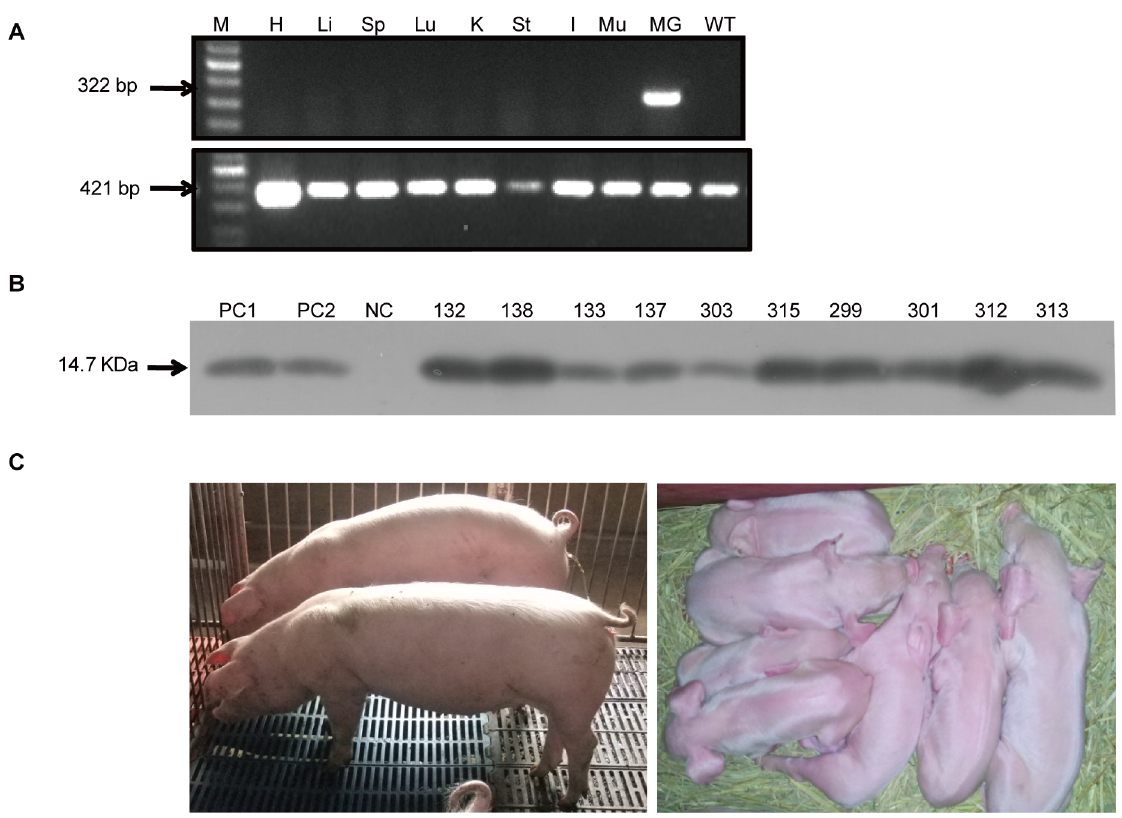
Fig 2. rhLZ expression in transgenic-cloned pigs. (A) RT-PCR analysis of RNA extracted from the mammary gland and other tissues of transgenic-cloned pigs. The sizes of RT-PCR products from rhLZ and GAPDH were 322-bp and 421-bp, respectively. M, 1-kb DNA ladder; WT, mammary gland tissue from wild-type pig; H, Li, Sp, Lu, K, St, I, Mu, and MG represent heart, liver, spleen, lung, kidney, stomach, intestine, muscle and mammary gland from transgenic pig, respectively.(B) Western blot analysis of rhLZ expression in transgenic pigs. Milk samples from transgenic-cloned sows on lactation day 1 were collected and detected by western blot analysis. PC1, 100 ng commercial natural hLZ standard; PC2, 50 ng commercial natural hLZ standard; NC, milk from WT pigs; lanes 4 – 13, diluted milk from transgenic-cloned pigs (dilution, 1:3, 3 μ L).(C) Image of F0 and F1 transgenic pigs. Left, 4-month-old F0 transgenic pigs; Right, F1 neonatal transgenic